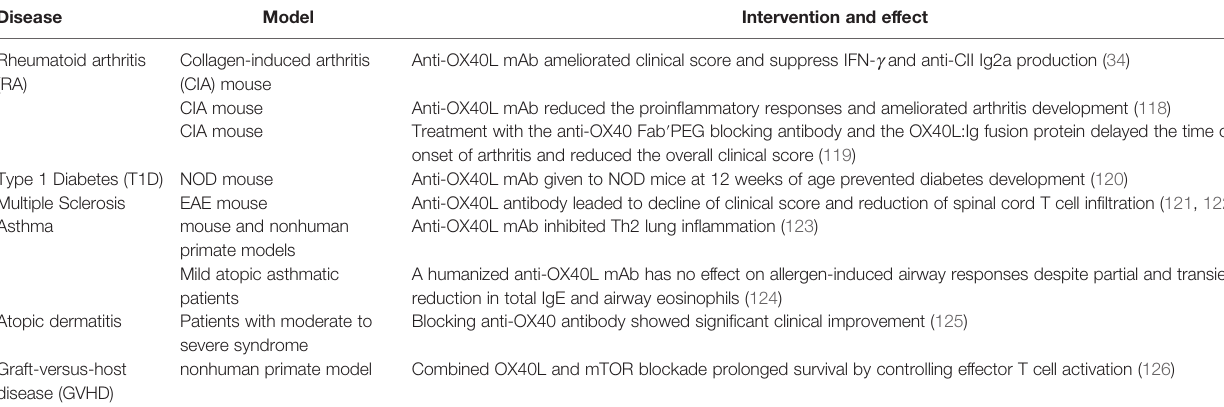
TABLE 3 | Therapeutic effects of OX40/OX40L blockade in vivo